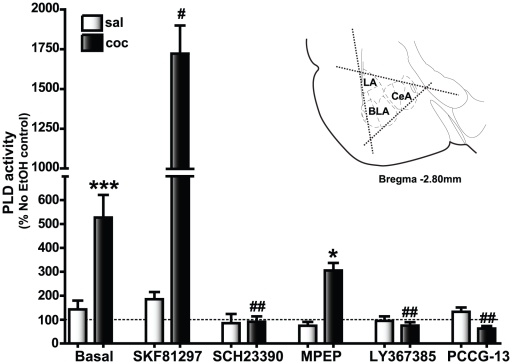
Basal PLD activity is strongly stimulated by the D1/5R agonist and blocked by the D1/5R, mGluR5, mGluR1, and the PLD-linked mGluR antagonists in the amygdala of cocaine CPP animals.The dotted line indicates PLD activity associated with control slices (no EtOH added) which was determined for each animal and used to calculate the change in PLD activity levels with EtOH and/or drug application. Basal levels represent the increase in PLD activity observed in the EtOH-treated slices compared to the no EtOH controls; *p<0.05 compared to the corresponding saline control and #
p<0.05 compared to the cocaine CPP group basal PLD activity. Basal PLD activity was significantly increased (***p<0.001, n = 50) in the cocaine CPP group (dark bars, 527.3±94.3) compared to the saline-treated group (white bars, 142.6±36.9). SKF81297, the D1/5R agonist, application increased the basal levels in the cocaine CPP group significantly (1722.0±176.9, n = 12, #
p<0.05) compared to the basal PLD activity observed with EtOH treatment alone in the same experimental group. The D1/5R antagonist, SCH23390, completely blocked basal PLD activity (91.2±21.9, n = 12, ##
p<0.01) in the cocaine CPP group. A similar reduction in PEtOH levels was observed with application of either the PLD-linked mGluR antagonist, PCCG-13 (62.9±10.6, n = 7, ##
p<0.01) or the mGluR1 antagonist, LY367385 (75.0±13.9, n = 12, ##
p<0.01), while the mGluR5 antagonist, MPEP, did not decrease basal PLD activity (305.7±31.5, n = 7, ns) within the cocaine CPP group but were significantly increased compared to (*p<0.05) the saline treated group. Applications of SKF81297 (184.9±30.5, n = 12), SCH23390 (84.9±38.9, n = 12), MPEP (74.2±16.3, n = 7), LY367385 (94.7±18.9, n = 12) and PCCG-13 (132.5±18.4, n = 7) did not significantly alter the PEtOH levels in the saline-treated group compared to the basal activity levels. Inset is a depiction of the triangular excision performed to isolate amygdala (bilaterally for each animal, each slice) containing the basolateral (BLA), the central (CeA) and the lateral (LA) subregions from three serial coronal slices (350 µm) beginning −2.30 mm to −2.80 mm from Bregma [127].